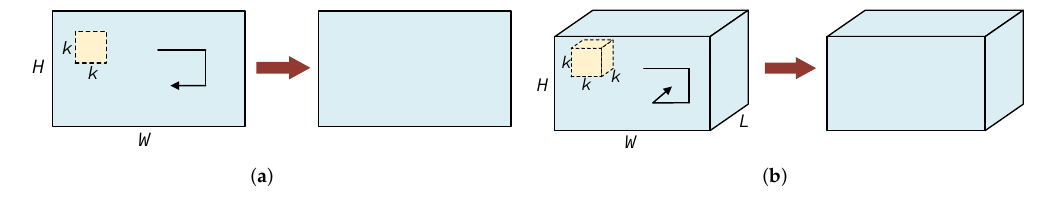
Figure 1. The illustration of 2D and 3D convolution operation adapted from [33]. ( a ) employing 2D convolution on an image. ( b ) employing 3D convolution on an image